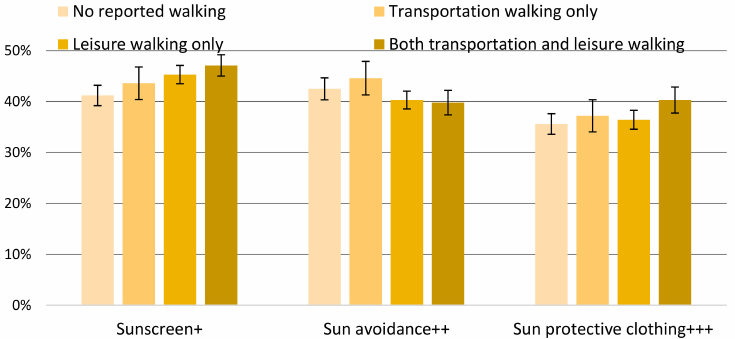
Figure 2. Weighted a and adjusted b prevalence (%) of sun-sensitive individuals c aged ≥ 18 years who reported regular sunscreen use d , sun avoidance e , and sun protective clothing f by walking category g , National Health Interview Survey, 2015. ( + no reported walking vs. both, p < 0.0001; no reported walking vs. leisure, p = 0.0001. ++ transportation vs. both, p = 0.02; transportation vs. leisure, p = 0.02. +++ no reported walking vs. both, p = 0.007; leisure vs. both, p = 0.01. a 95% confidence interval. b Covariates: Gender, age, ethnicity, education, marital status, foreign-born status, needs walking assistance, U.S. Census region, obesity or overweight, physical activity level, smoking status, binge drinking, tanning bed use, ever had a skin exam, ever had cancer, family history of melanoma, personal history of melanoma, sunless tanning product use, sunburn previous 12 months, skin reaction to sun after two weeks, and health insurance status. c Sun-sensitivity defined as reporting any skin burn when not protected from the sun for 1 h. d Regular sunscreen use was defined as always or usually using sunscreen with SPF15 + (sun protection factor). e Response of always or usually staying in the shade or responding not going into the sun for any sun protective question. f Response of always or usually wearing long sleeve shirt, long clothing to the ankles, or a wide-brimmed hat on a warm sunny day. g Reported walking categories for at least 10 min in the past seven